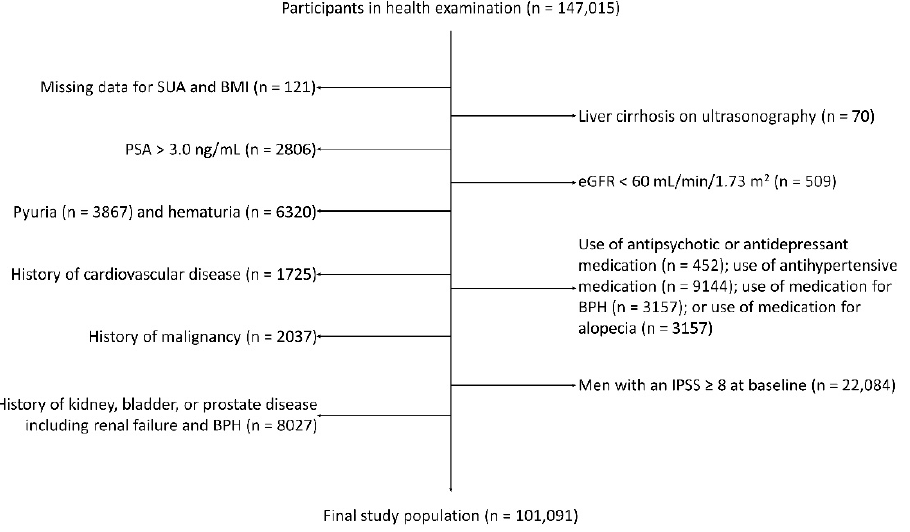
Figure 2. Selection of the study population. BMI, body mass index; BPH, benign prostate hyperplasia; eGFR, estimated glomerular filtration rate; IPSS, International Prostate Symptom Score; PSA, prostate specific antigen; SUA, serum uric acid.